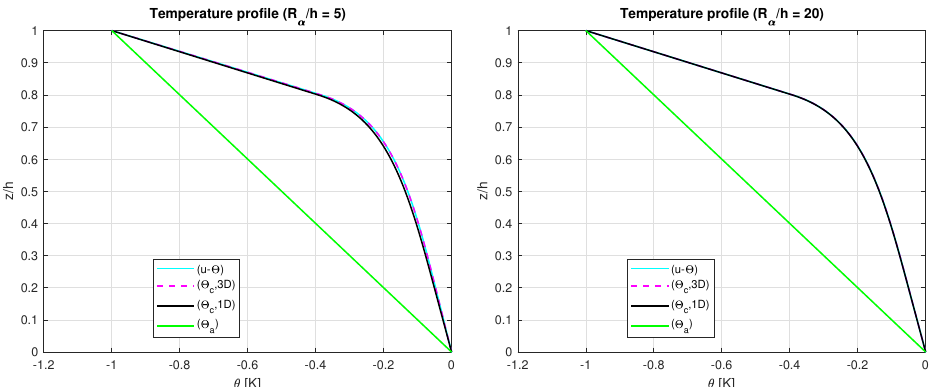
Figure 9. Third benchmark, temperature profiles for thick and moderately thick simply supported sandwich cylindrical shells with FGM ( p = 2) core. The maximum amplitude of the temperature θ ( α , β , z ) is evaluated at the centre of the cylindrical shell at ( a /2, b